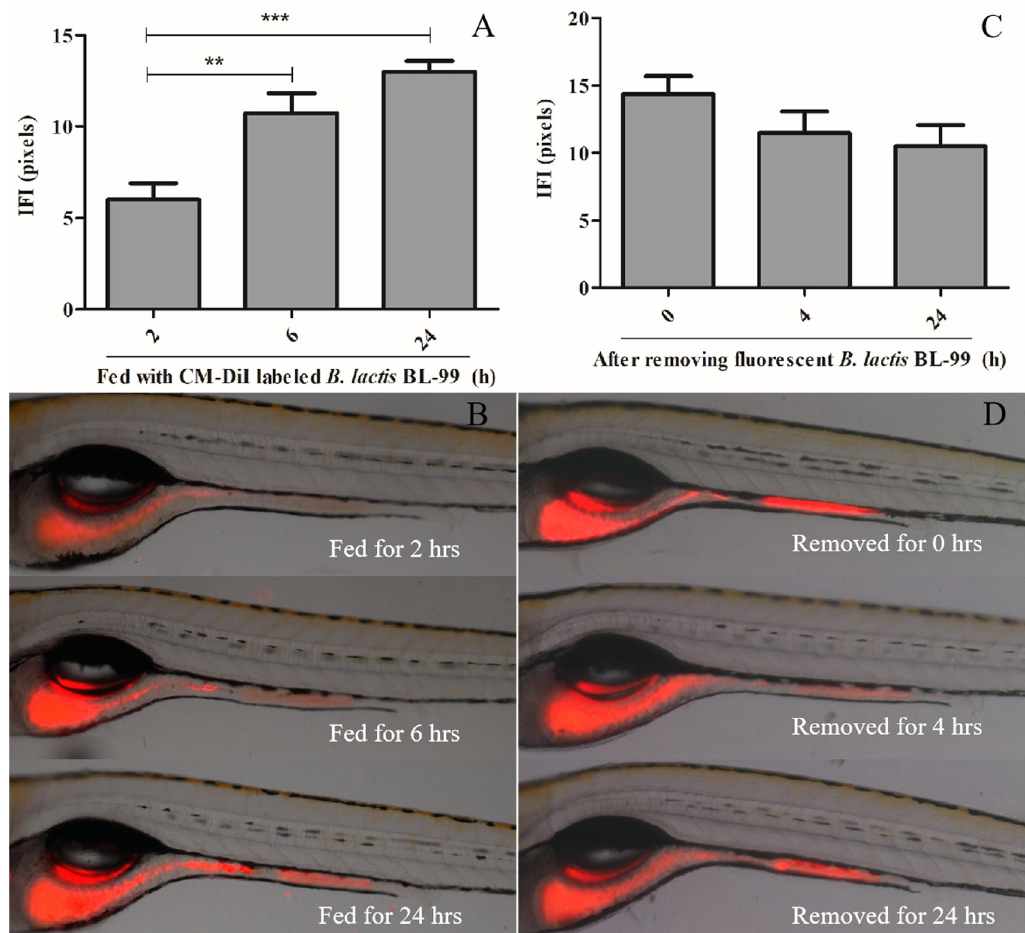
Fig 1. The retaining and lasting time periods of B . lactis BL-99 in the larval zebrafish intestinal tracts. The larval zebrafish were fed with CM-DiI labeled B . lactis BL-99 for 2, 6 and 24 hrs, the fluorescent intensities (A) and quantitative analyses (B) in the larval zebrafish intestinal tracts. After removing fluorescent B . lactis BL-99 from the treatment solutions and transferred the zebrafish to fresh fish water for 0, 4 and 24 hrs, the larval zebrafish intestinal fluorescence (C) and quantitative analyses (D). Data were expressed as means ± S.E.M. Compared with the model group, �� p < 0.01, ��� p < 0.001. IFI = intestinal fluorescent